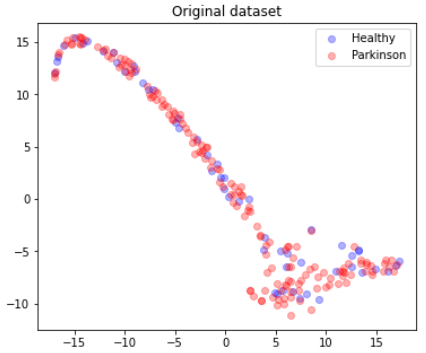
Figure 7. Dataset points distribution according to health status.